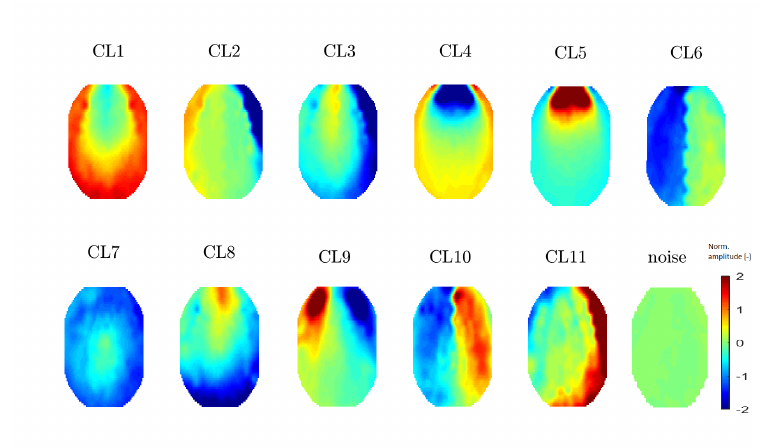
Figure 8. Mean topomaps representing 11 clusters after using the t-SNE method with a perplexity of 20. The mean and median topomaps have similar characters but the variance has no meaningful value, similar to the case with perplexities of 30 and 40. Topomaps were clustered from IC